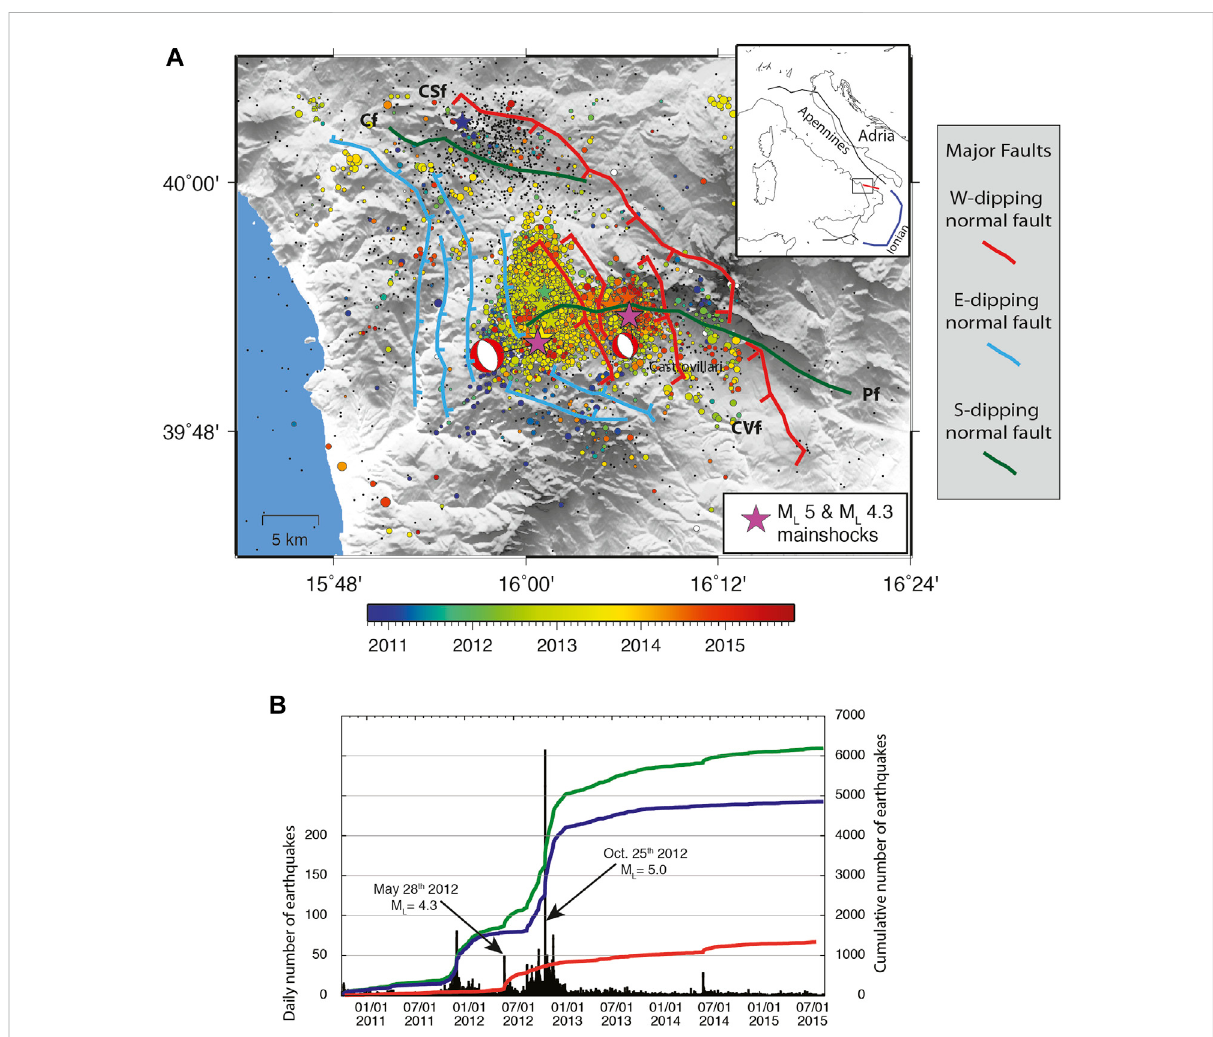
FIGURE 1 (A) Map of the 2010 – 2015 seismic sequence/swarm from ISIDe Working Group (2016), https://doi.org/10.13127/ISIDE. The size of the epicenters is proportional to the magnitude. Stars are the largest events (M L > 3.5), including the two mainshocks. Earthquakes are color-coded